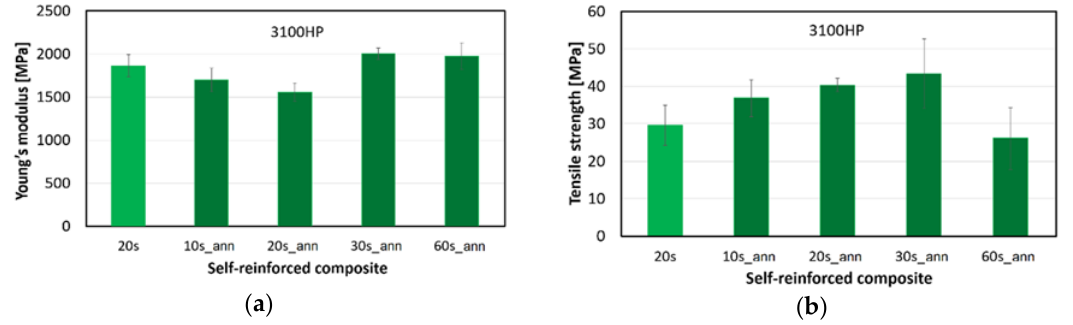
Figure 8. Young’s modulus ( a ) and tensile strength ( b ) of SR composites made of annealed (ann) and non ‐ annealed PLA mats, indicating the hot compaction time (10–60 s).